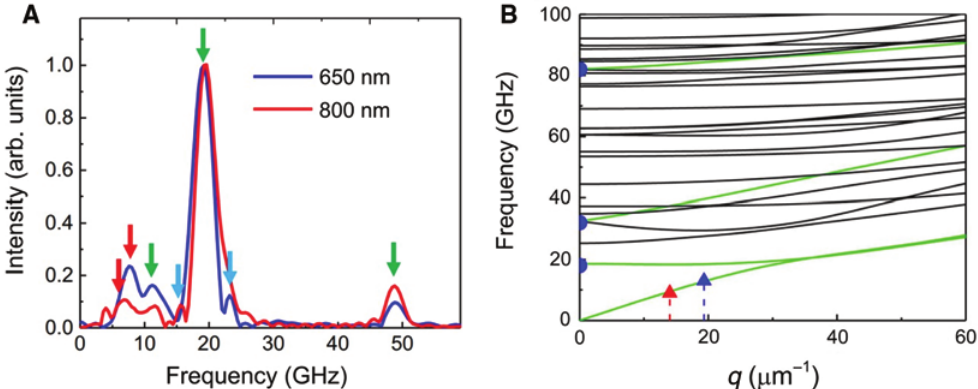
Figure 18: Scattering of light by phonons in nanowires. (A) Normalized Fourier transform of the transient reflectivity traces obtained with a pump wavelength of 550 nm and probe wavelength of either 650 or 800 nm. The green (red and blue) arrows points at the frequencies that are unchanged (changed) with varying probe wavelength. Reprinted with permission from [50]. Copyright (2016) by The American Physical Society. (B) Experimentally obtained frequency of phonons of a GaAs zinc-blende nanowires and the fitted phonon dispersion relations. Reprinted with permission from [85]. Copyright (2016) American Chemical Society.